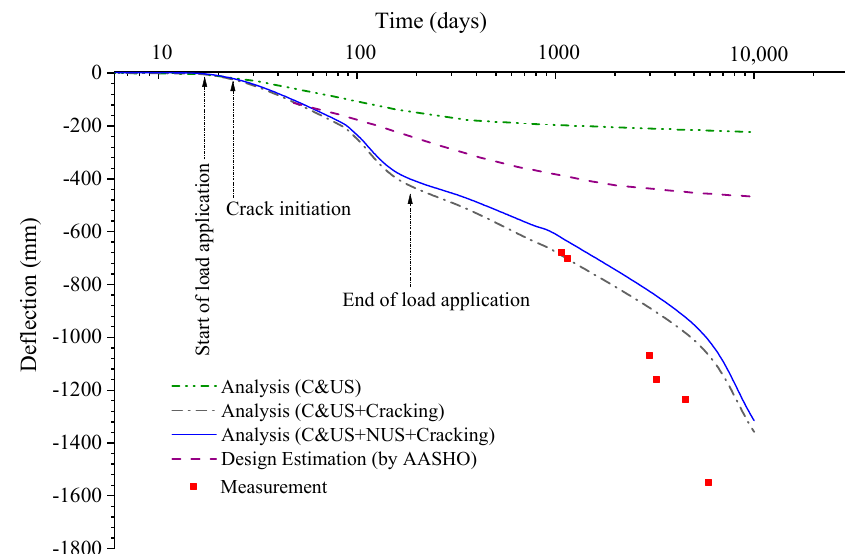
Figure 19. Variation of 2nd moment of area, deflection owing to nonuniform shrinkage, and equivalent moment and load along the span of Koror–Babeldaob Bridge.